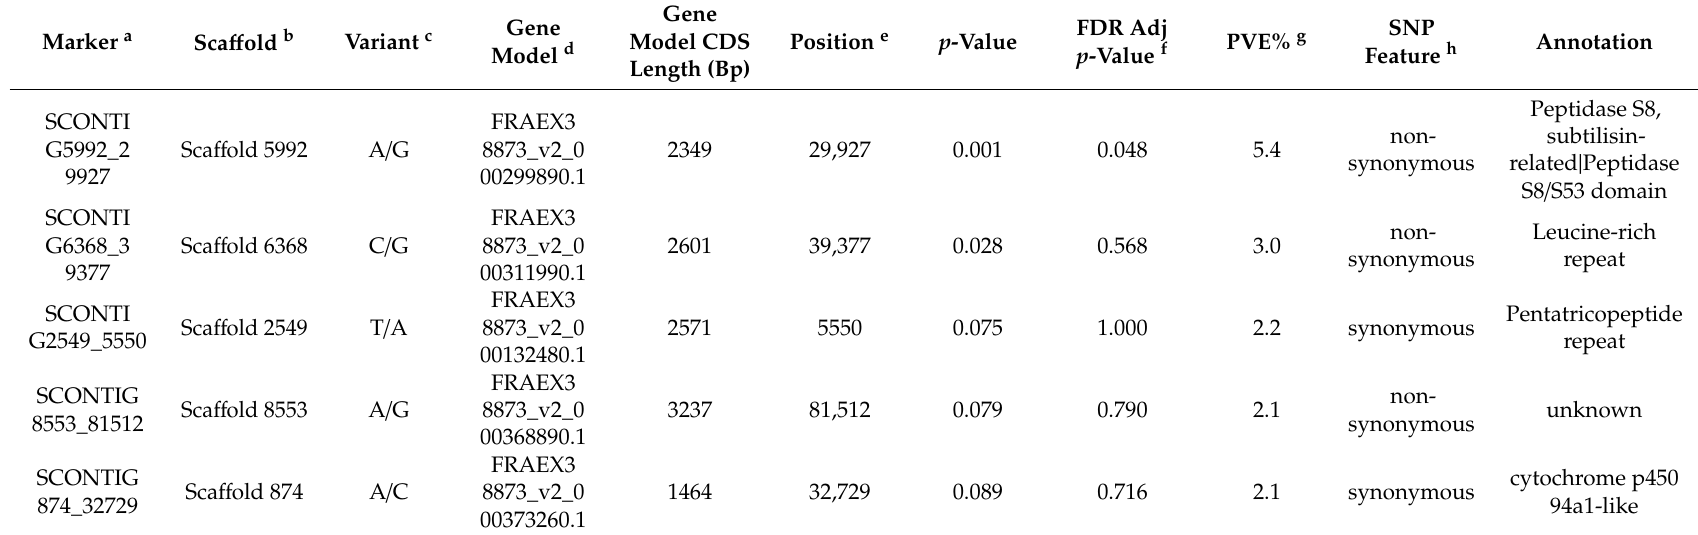
a SNP marker, the SNP name was composed of the sca ff old number and SNP position on sca ff old; b sca ff old name in ash genome; c variation in major and minor allele frequency; d unique gene model in ash genome; e position of SNP in the gene model; f adjusted p -value (false discovery rate) by Benjamini–Hochberg method; g percentage of phenotypic variance explained; h SNP